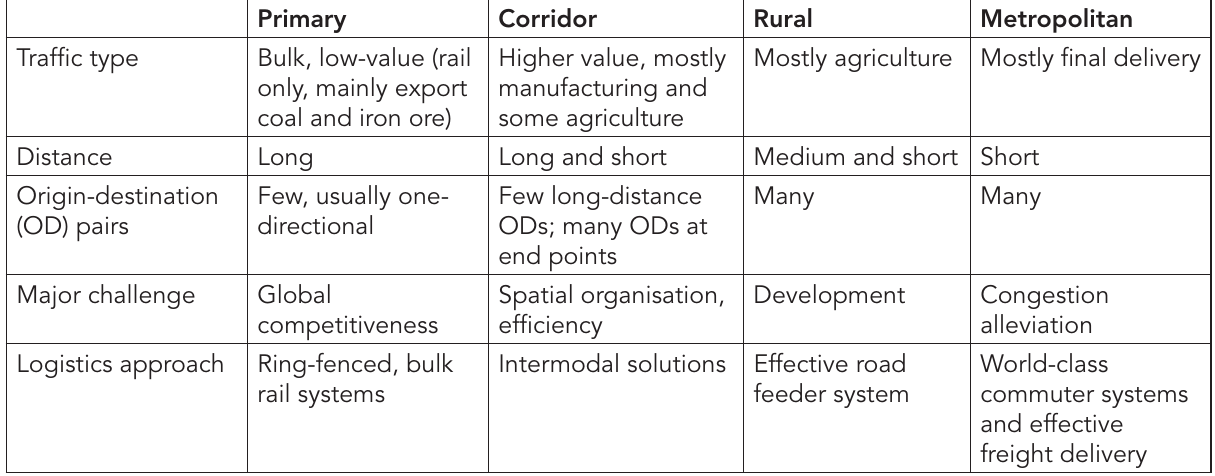
Table I: Definition of transport typologies (Havenga, 2007: